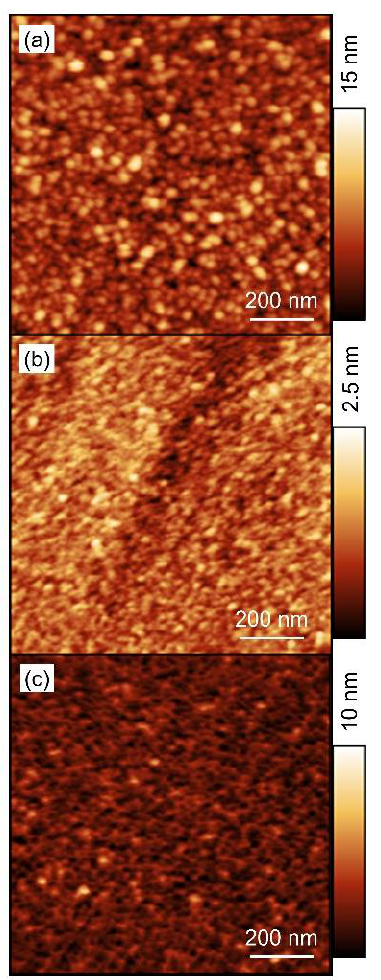
Figure 5. AFM micrographs of LT FME AlN samples: ( a ) A1, AlN grown with DMHy, ( b ) A2, AlN grown with NH 3 , and ( c ) A3, AlN grown on LT GaN with both layers grown with NH 3 . Scale bar at right goes from 0 nm to range given.